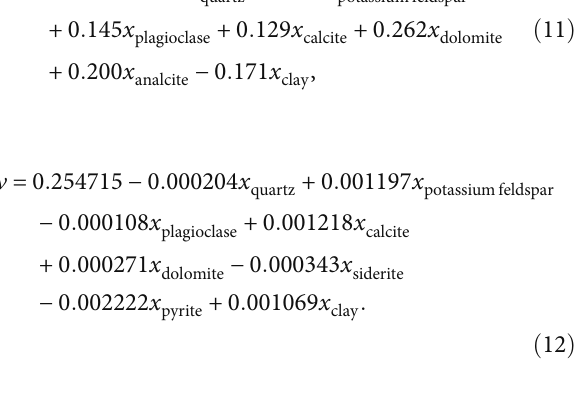
Figure 8: Probability distribution map of Poisson ’ s